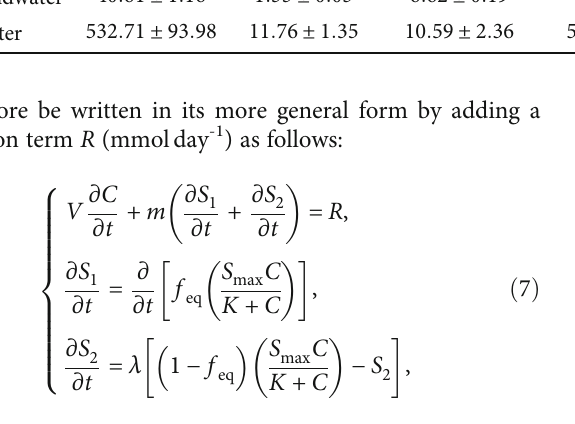
Table 2: Major cations and anions of groundwater and seawater samples. Water